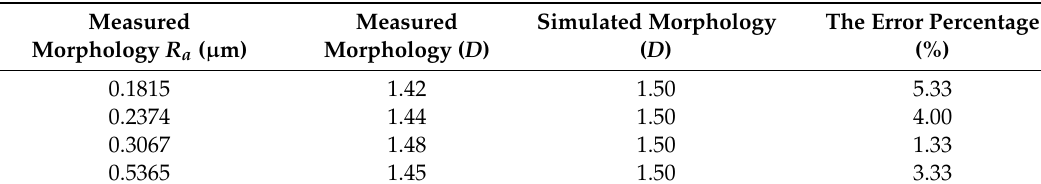
Table 4. Error percentages of simulated and actual morphologies.